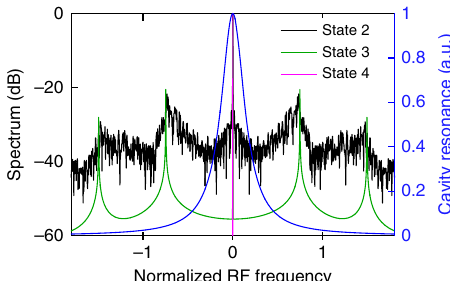
Figure 5 | Breathing frequency dependence on the effective pump-cavity detuning. The effective pump-cavity detuning in the Si microresonator is extracted from the three-photon-absorption-induced photocurrent based on the relationship with the soliton peak power and thus in arbitrary units (a.u.). The same trend is also observed in a Si 3 N